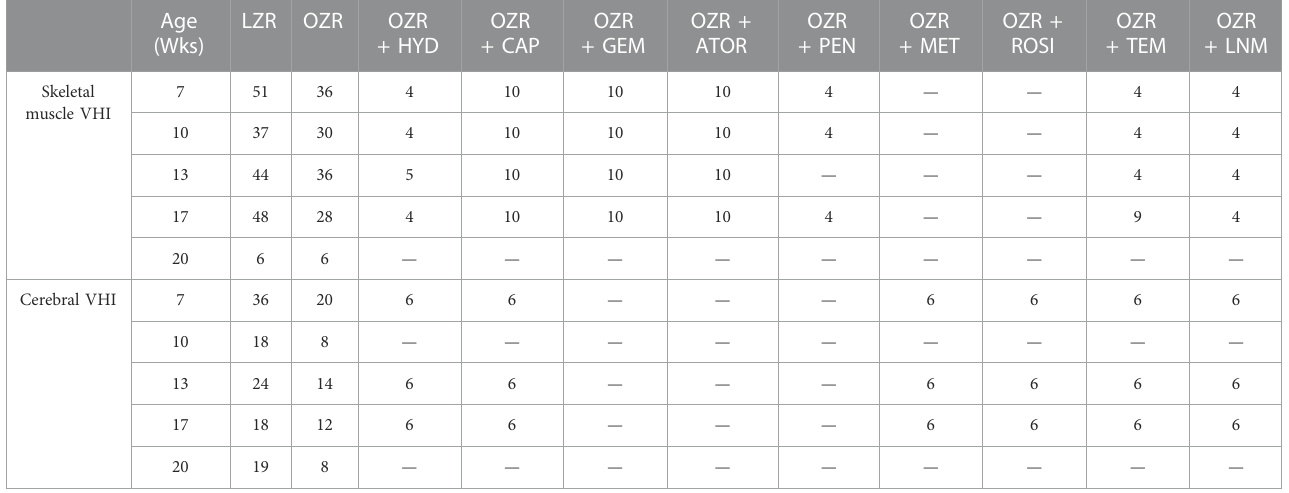
TABLE 2 Animal numbers used inthe present study. Data are presented for each group of animals and at each agefor both the peripheral and cerebral vascular health index (VHI)